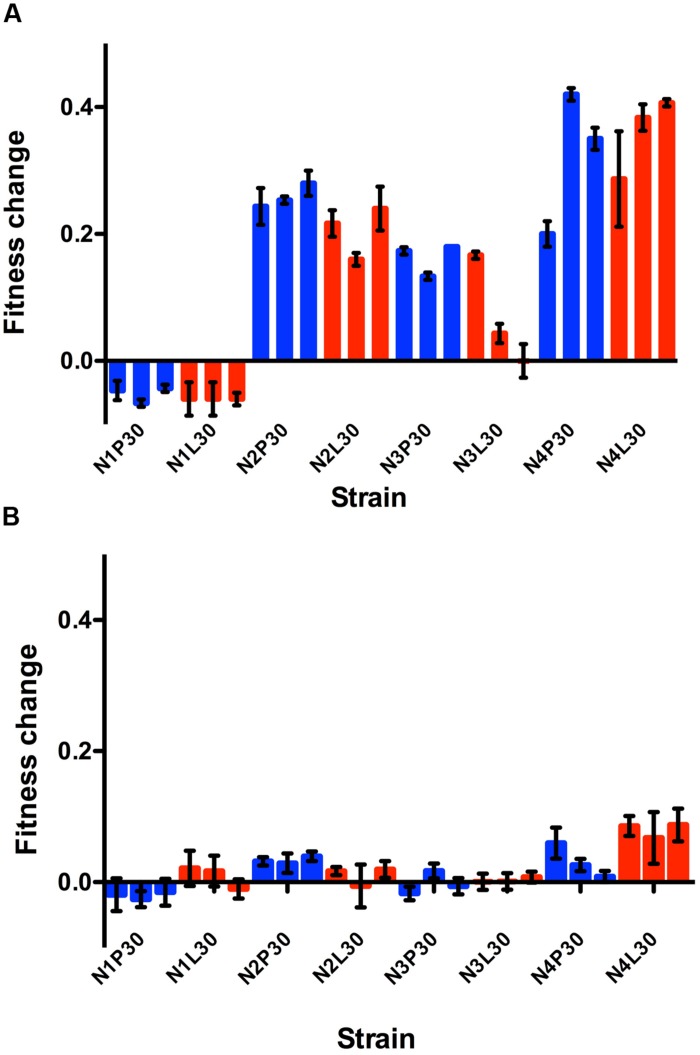
Relative fitness is shown for each evolved replicate calculated after growth in PC-3 cells (A) or LNCaP cells (B). Viral productivity was measured at 24 h post infection in each cell type, as assayed by titration in BHK-21 cells. Fitness was calculated as 1-log (evolved virus production/ancestral virus production). Blue bars are for lineages passaged through PC-3 cells while red bars depict lineages passaged through LNCaP cells. Three replicates were infected and assayed for each evolved cell type, and the SE is shown.